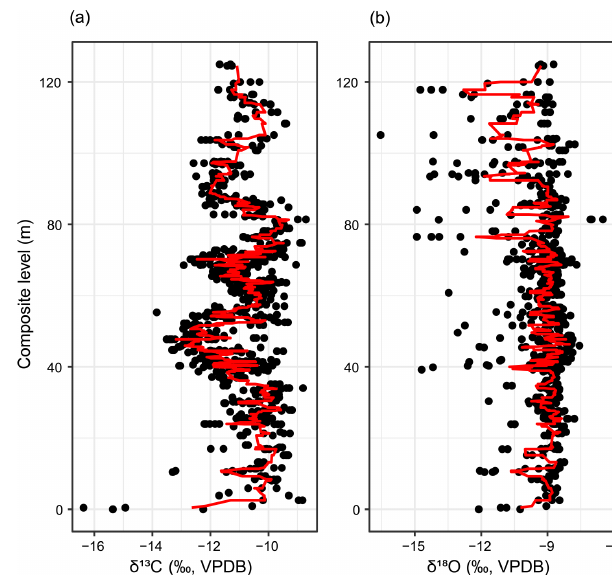
Figure D1. Pedogenic carbonate δ 13 C (a) and δ 18 O (b) according to their composite stratigraphic level. Points represent individual sample measurements. The red line is a seven-point moving aver- age through the values. This composite section includes the Basin Draw and D-1454 sections, with the top of the Basin Draw section correlated with the lowest CIE